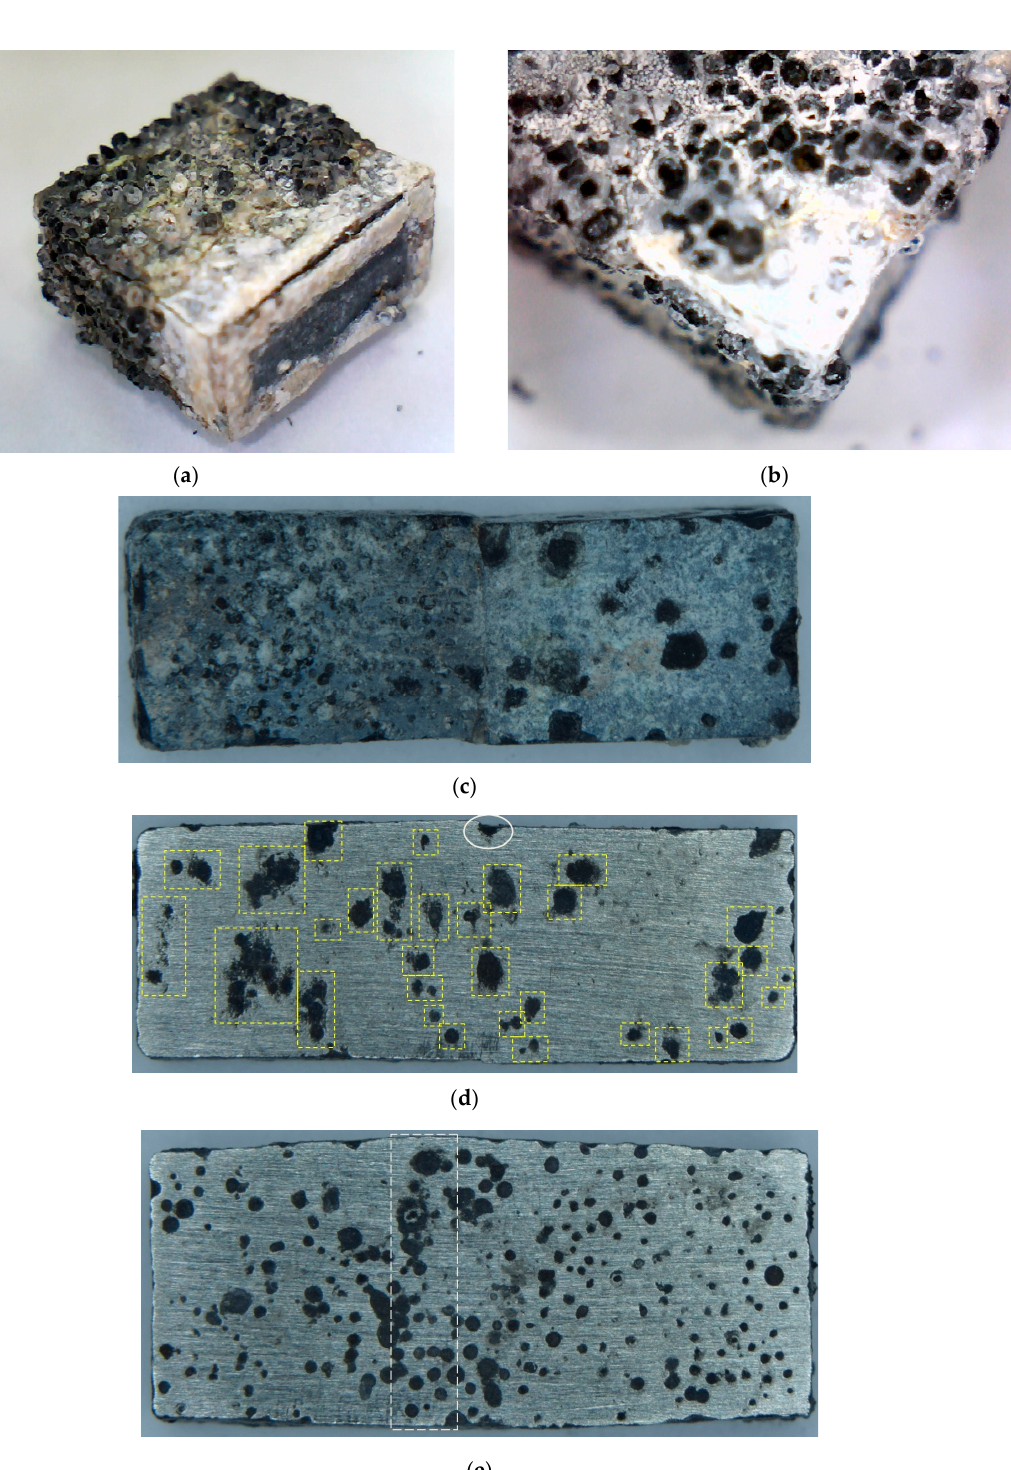
Figure 5. Photographs of the alloy specimens after HSC testing ( a , b ), after rinsing in a hot water flow ( c ), and after mechanical polishing ( d , e ). In ( d ), the largest corrosion pits are highlighted by a yellow dashed line. The white solid line outlines a joint macrodefect, which the crevice corrosion and the pitting one go through simultaneously. In ( e ), the welded joint area (Zone I, see Figure 1c) is outlined by a white dashed line.